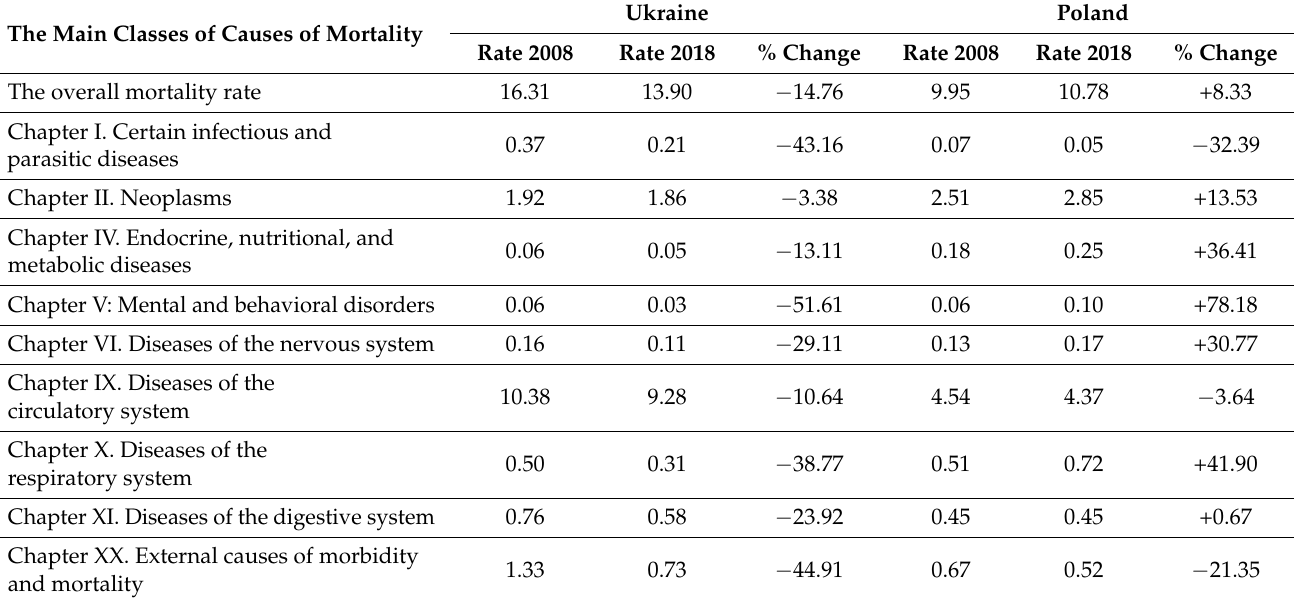
Table 1. Mortality rates in Ukraine and Poland per 1000 people by main classes of causes of death.